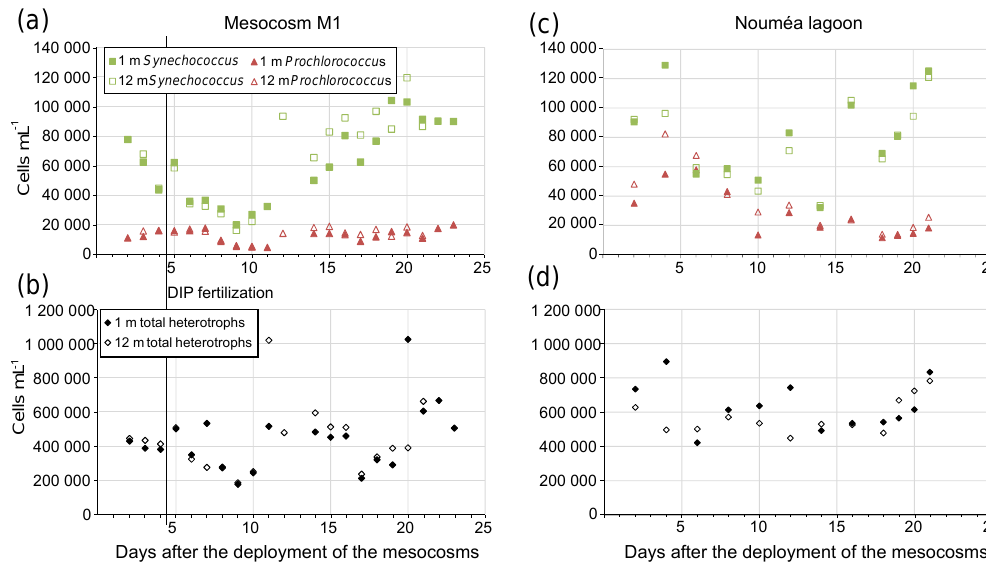
Figure 2. Evolution of absolute abundances as counted by flow cytometry at depths of 1 and 12m of Synechococcus and Prochlorococcus in M1 (a) and the lagoon (c) ; evolution of non-photosynthetic bacteria (total heterotrophs) in M1 (b) and the lagoon (d)